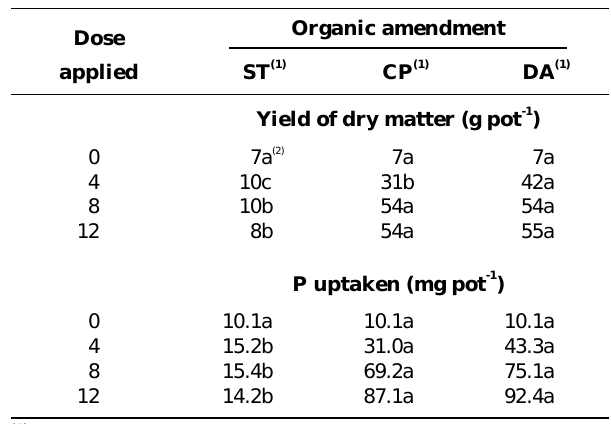
Table 1. Effect of four organic amendments on the yield of dry matter and P uptaken by corn plants grown on the Aquatibia soil